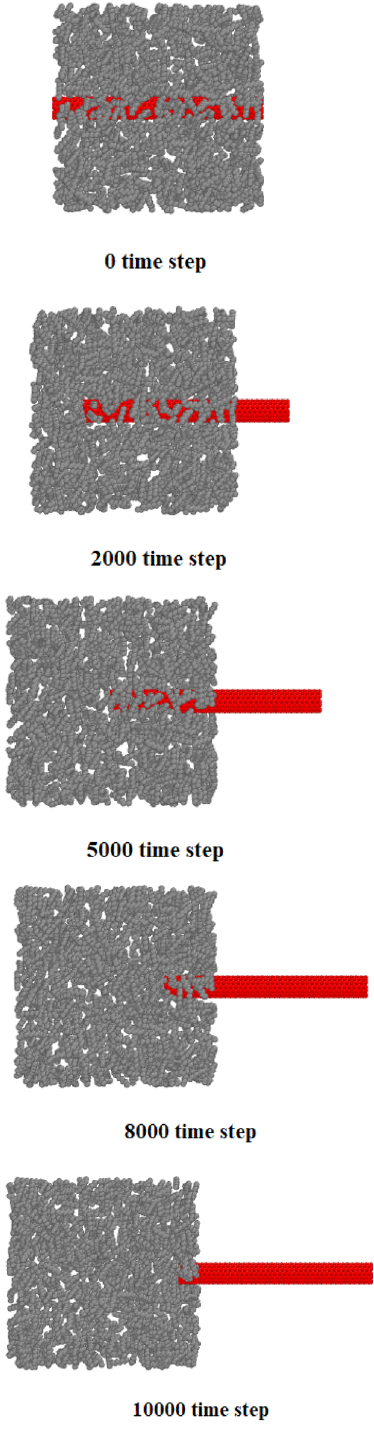
Figure 9. Schematic diagram of the CNT pullout process from the pristine matrix as a function of MD simulation time